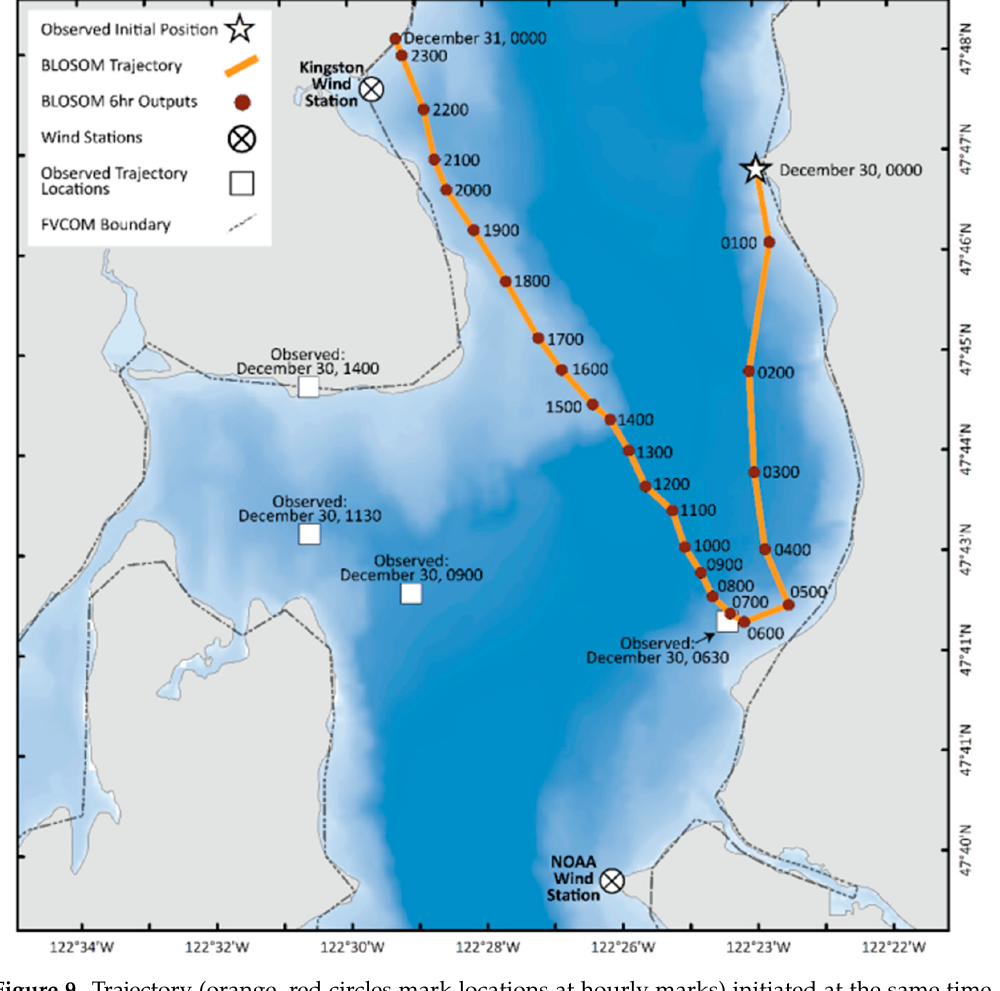
Figure 9. Trajectory (orange, red circles mark locations at hourly marks) initiated at the same time and location as the oil spill, resulting from forcing exclusively with 6% of the wind from the NOAA wind station. Also shown are the locations of NOAA (NDBC-WPOW1) and Kingston wind stations (white circles with black cross) and the approximate locations of oil at different times, as observed from overflights (white squares; see Figure 4).